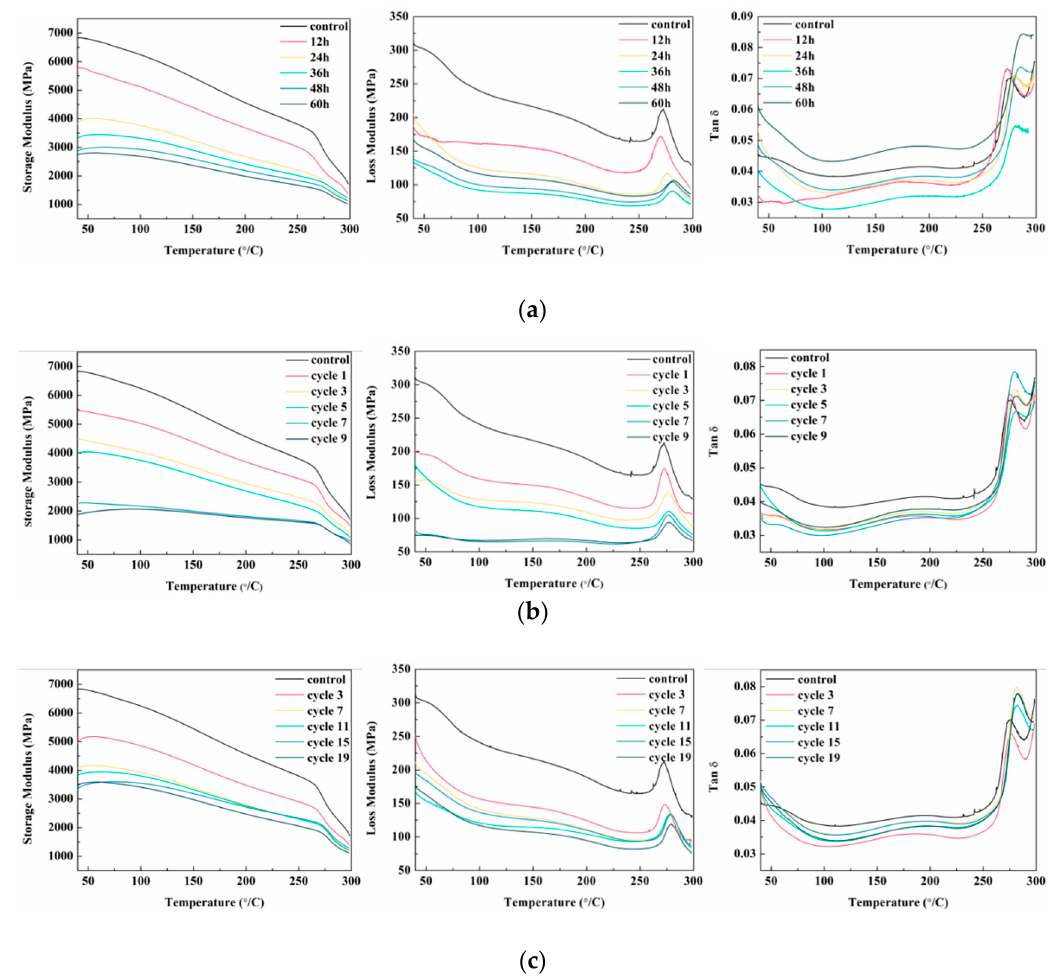
Figure 2. Dynamic thermomechanical properties: ( a ) from left to right, E ′ , E ″ , tan δ under damp–heat treatment; ( b ) from left to right, E ′ , E ″ , tan δ under freeze–thaw cycle; and ( c ) from left to right, E ′ , E ″ , tan δ under artificial weathering cycle.